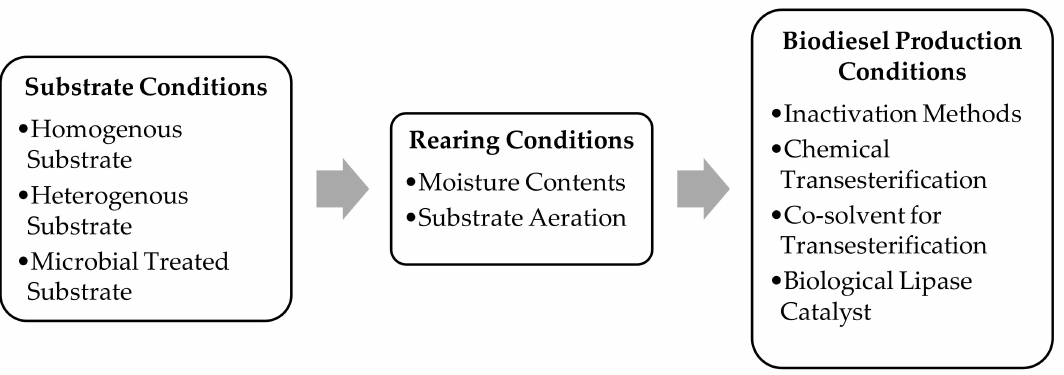
Figure1. Flowofreview, encompassingthelarvalsubstrate,